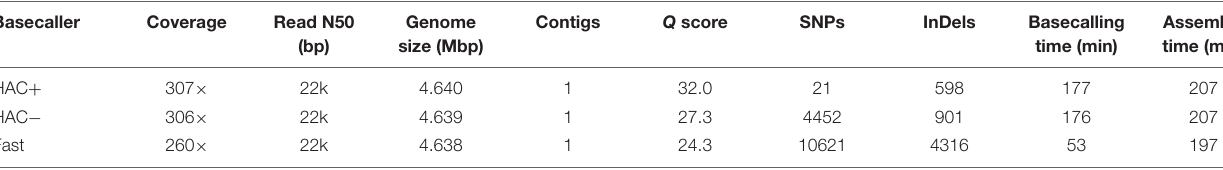
TABLE 1 | Summary of assembly statistics for E. coli strain K12 substr. BOP27. Basecaller